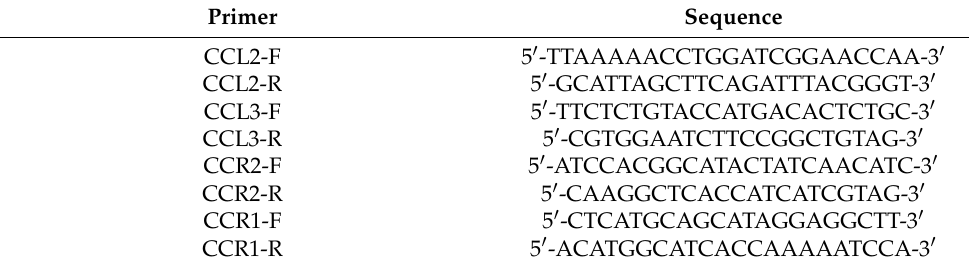
Table 1. Sequences of